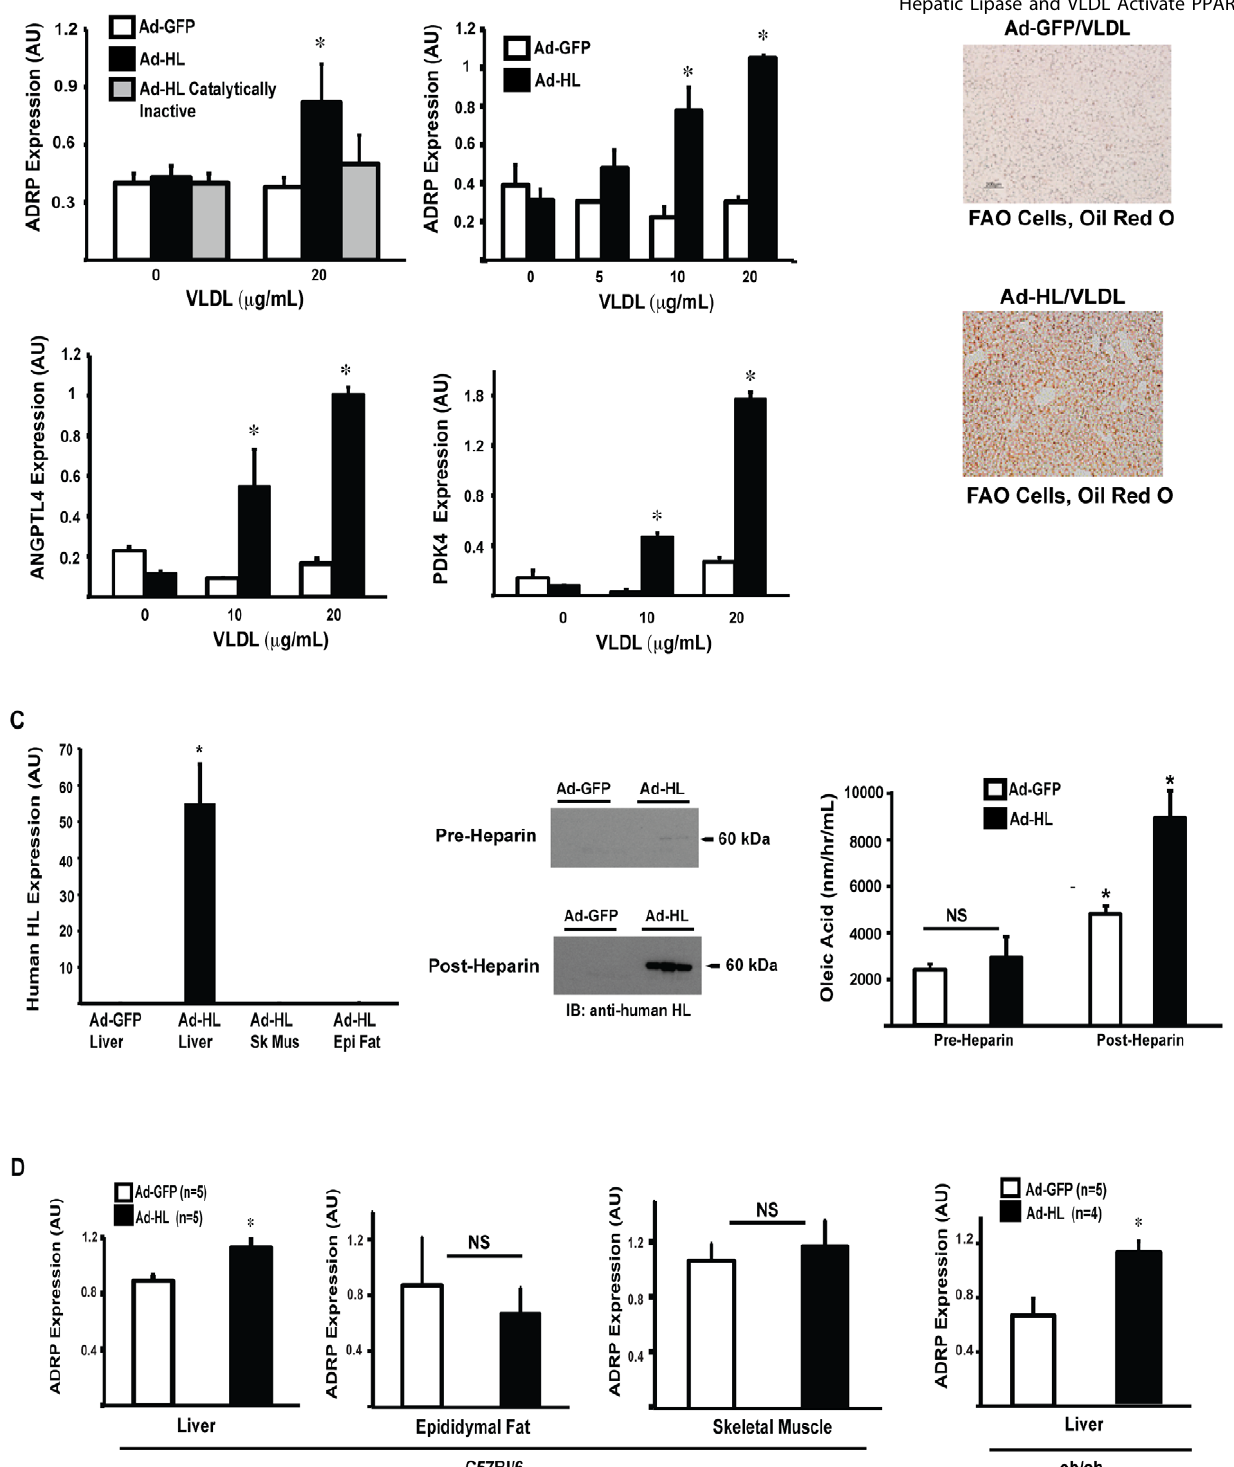
Figure 4. HL/VLDL increases expression of PPAR d target genes, invitro and invivo . (A) Left Panel. FAO hepatoma cells were infected with adenovirus GFP, adenovirus HL and adenovirus catalytically inactive HL for 24 hours in serum free medium. After 12 hours stimulation with lipoprotein, RNA was harvested for gene expression analysis and results are expressed as before. *p , .05 vs. GFP. (A) Right Panel. The concentration dependent effect of VLDL induction of ADRP mRNA in HL-expressing FAO cells is shown. (B) Oil Red O staining. FAO hepatoma cells treated with adenovirus GFP and HL along with VLDL 50 m g/mL were fixed in paraformaldehyde overnight then stained with Oil Red O to mark neutral lipid accumulation. Magnification 10 6 . (C) C57BL/6 (8 week, males) were injected by tail vein with adenovirus GPF or human HL constructs, 1 6 10 11 viral particles, 100 m L volume. Five days following adenovirus infection, plasma was collected pre-heparin and 30 minutes post heparin injection (intraperitoneal, 200 U) for HL activity and protein expression; mice were euthanized and tissue was harvested for RNA isolation for gene expression analysis. *p , .05 vs. GFP. RT-PCR results expressed as relative copy number in arbitrary units. (D) C57BL/6 and ob/ob mice (6–8 week, male) underwent tail vein injection as above. Five days later tissue was harvested for gene expression. *p , .05 vs. GFP. RT-PCR results expressed as relative copy number in arbitrary units.